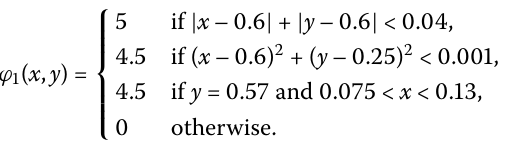
Table 1 The number of iterations and CPU for the linear problem of the non-smooth obstacle ϕ 1 (5.3) ( ε = 10 –6 ) PDL1P Resolution